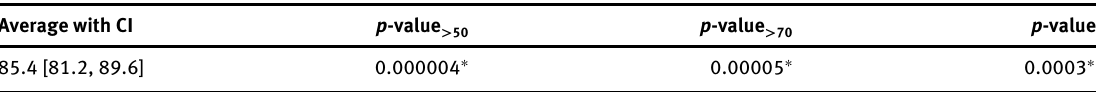
Table 4: SUS analysis. Average with